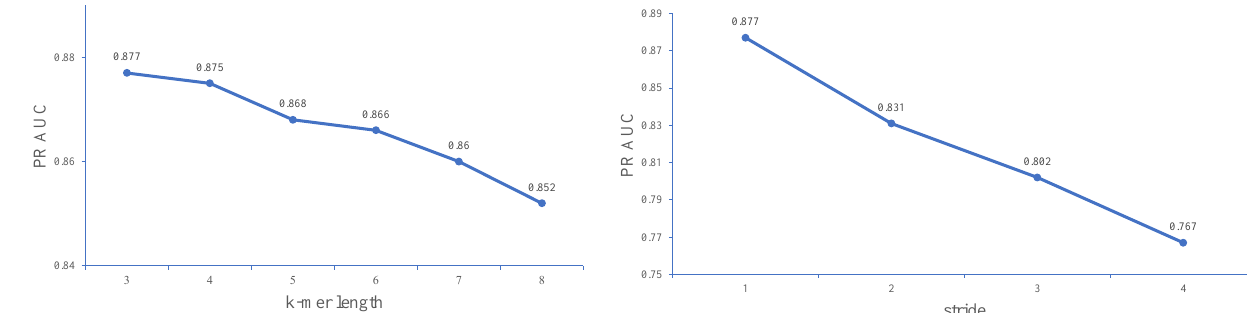
Figure 3. A comparison of DeepD2V with different k -mer length and stride step on the 23 ChIP-seq datasets in a Gm12878 cell line under the PR AUC